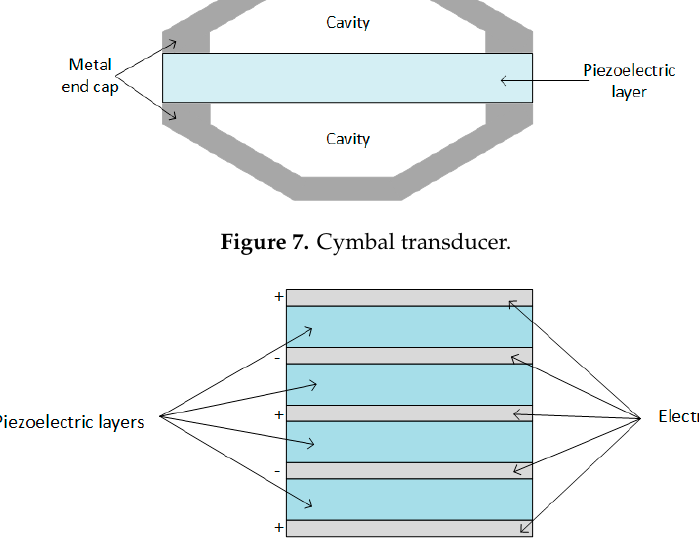
Figure 8. Stack piezoelectric